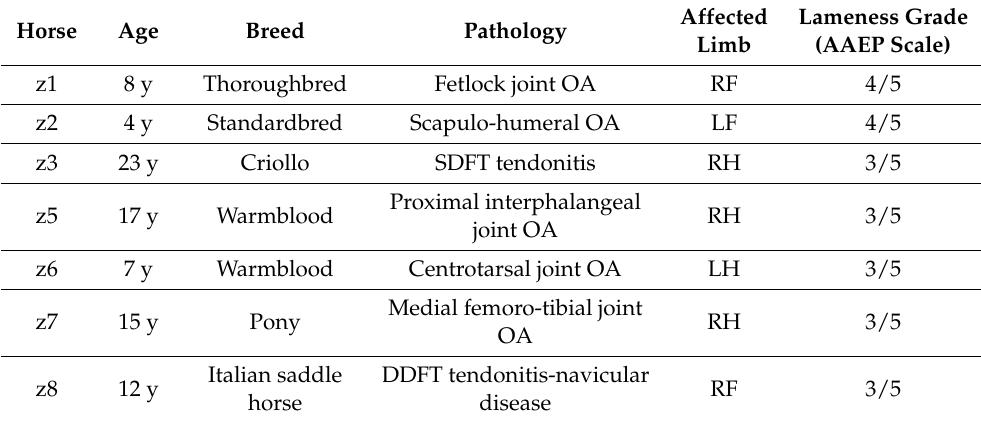
Table 1. Signalment, source, and severity of lameness in horses belonging to the lame group.